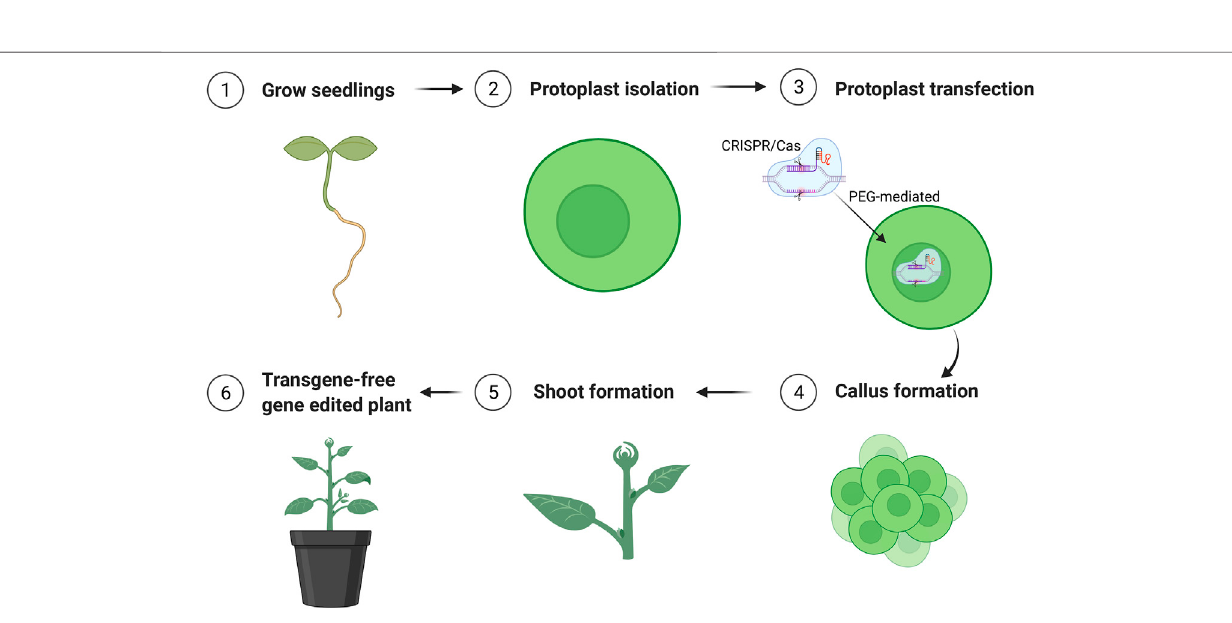
Frontiers in Genome Editing |